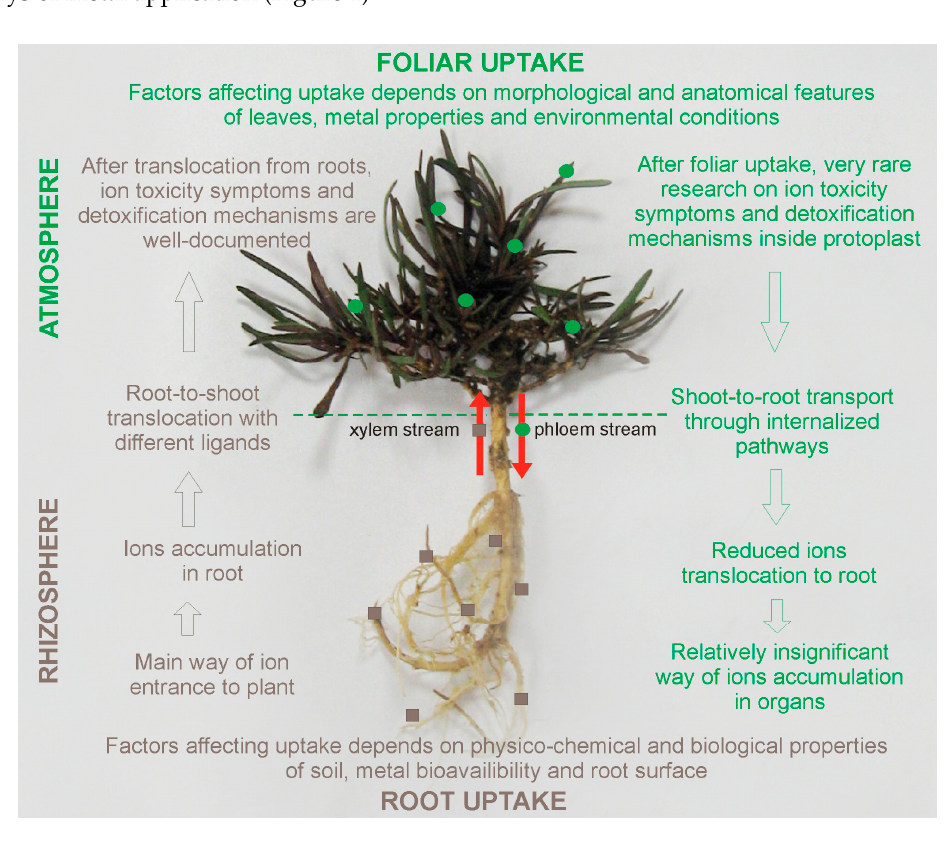
Figure 1. Comparison of pathways that are involved in metallic elements uptake and distribution in plants. Modified from Shahid et al. [37]. Photo of Gypsophila fastigiata calamine ecotype provided by E. Muszy ń ska.